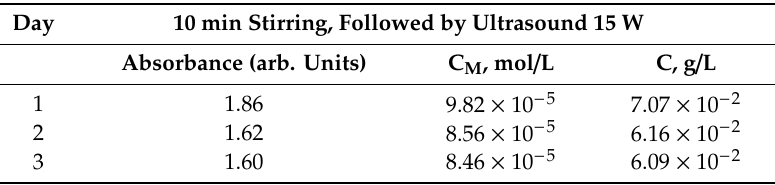
Table 1. Dynamics of stability of 2% aqueous solution of C 60 in TWEEN 80.